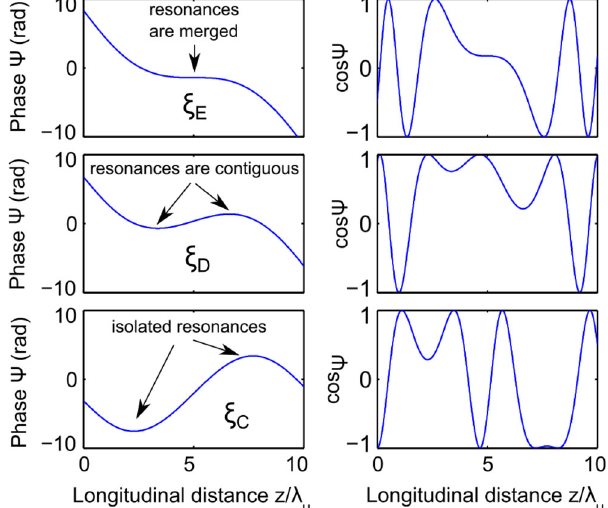
FIG. 12. Illustration of the ponderomotive phase behavior for a parabolic undulator profile f